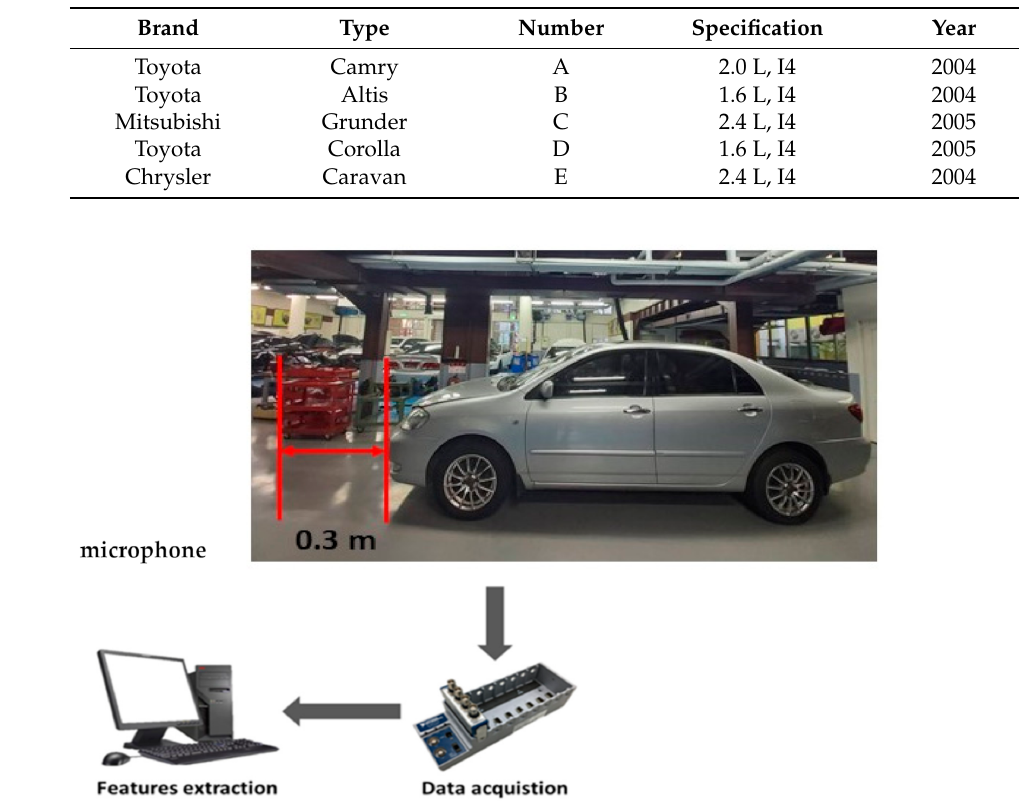
Figure 7. Experimental setup and process of